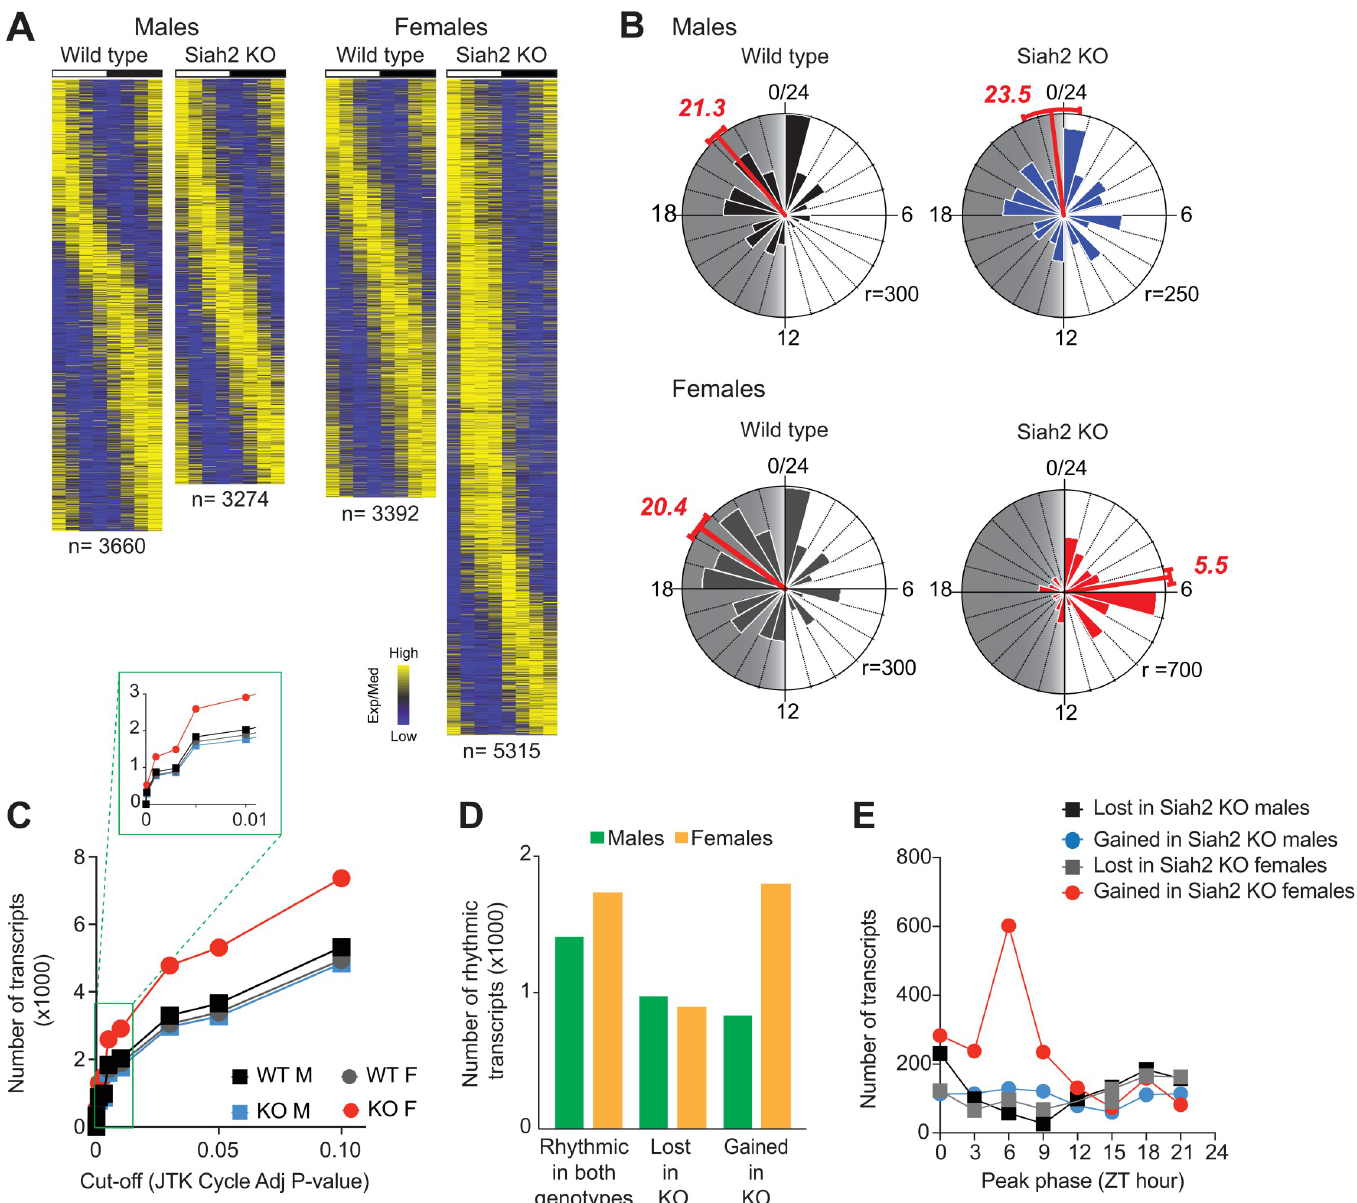
Fig 2. SIAH2 loss selectively remodels the female circadian transcriptome towards the daytime. ( A ) Heatmaps of expression profiles of the rhythmically expressed genes (JTK cycle adj p < 0.05), sorted by peak expression timing/phase for each group independently. White/black bars indicate the light-dark cycle. ( B ) Raleigh plots (circular histograms) of expression peak timing for all rhythmically expressed genes in each group. The numbers in red depict the average peak-time (in ZT hours) indicated by vector analysis (red line, +/- 95% CI). Gray shading = nighttime, r = radius in number of genes. C. Numbers of ‘rhythmically’ expressed genes in each group at various statistical cut-offs. ( D ) Comparisons of SIAH2-induced changes to rhythmicity of genes in each sex. ( E ) Frequency distribution of expression peak timing, across the day, of genes that gained or lost rhythmicity in SIAH2-deficient (Siah2 KO) livers in both sexes. rhythmicity in Siah2 -/- females did so with peak expression strongly clustered around mid-day (ZT6, Fig 2E), accounting for part of the overall shift in timing from night time to daytime. In contrast, changes in gene expression in males lacked phase clustering (Fig 2E). The large bias in the timing of expression of genes in females suggests that SIAH2 may regulate a female-spe- cific transcriptional mechanism that regulates gene expression specifically around mid-day.